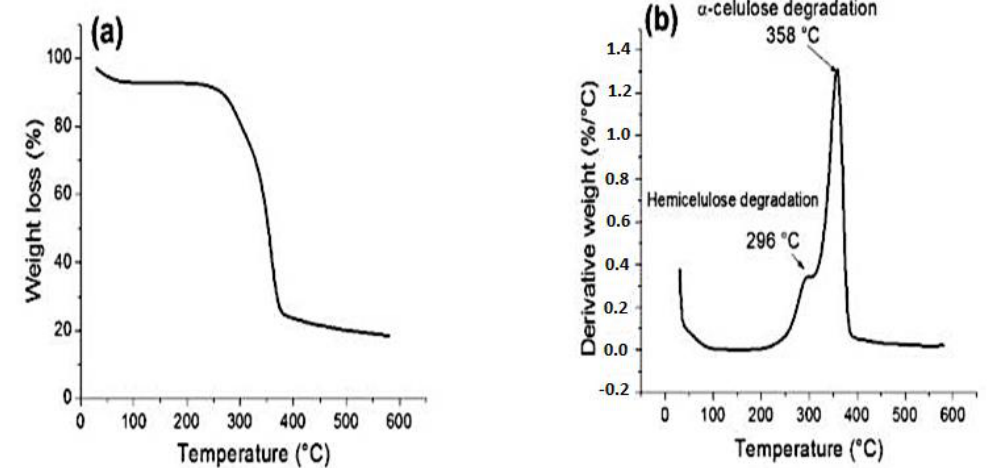
Figure 12. ( a ) TG and ( b ) DTG curves of fique fibres [161] (reprinted with permission from Elsevier, Licence Number: 5494340333464).